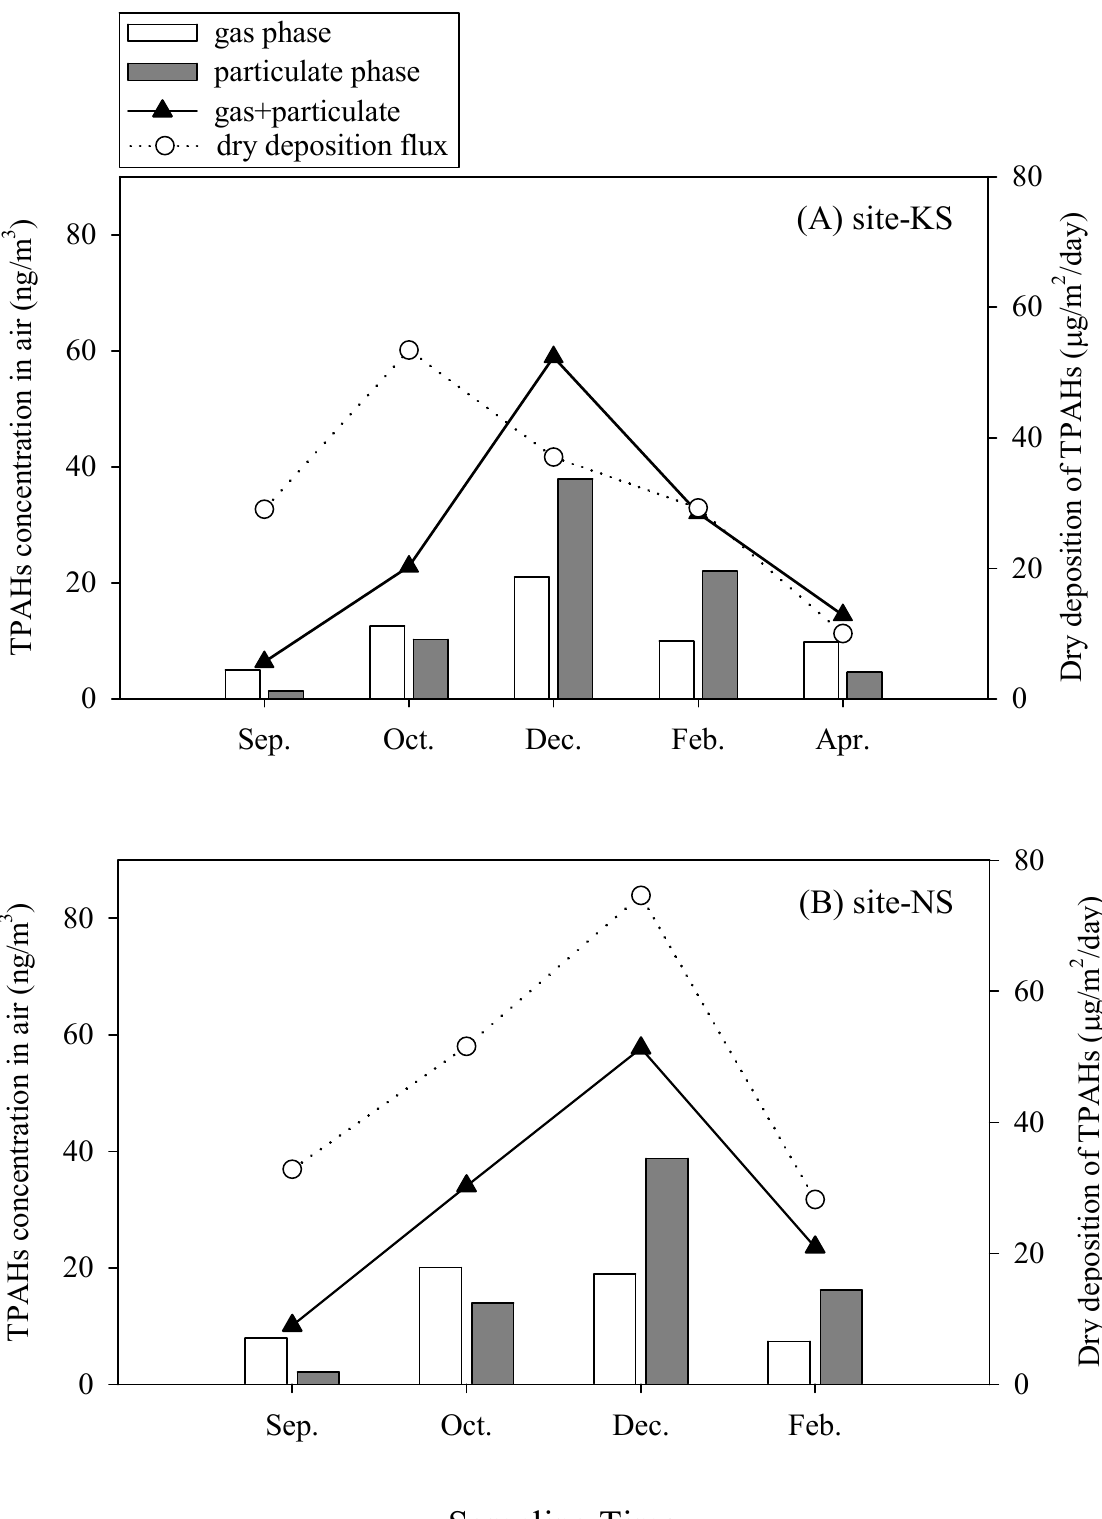
Figure 2. Temporal variation of atmospheric TPAHs concentrations and dry deposition flux of particulate TPAHs measured at (A) suburban and (B) urban sites. TPAHs denotes the sum of gaseous and particulate PAHs for 15 compounds (listed in Table